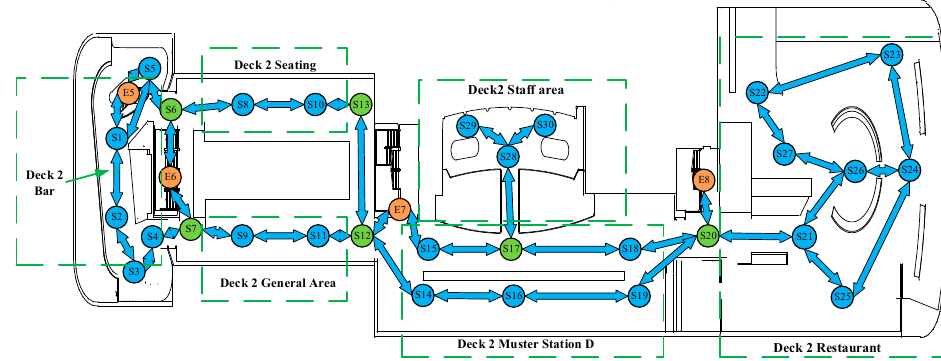
Figure 6. Third-tier node diagram of the cruise ship.